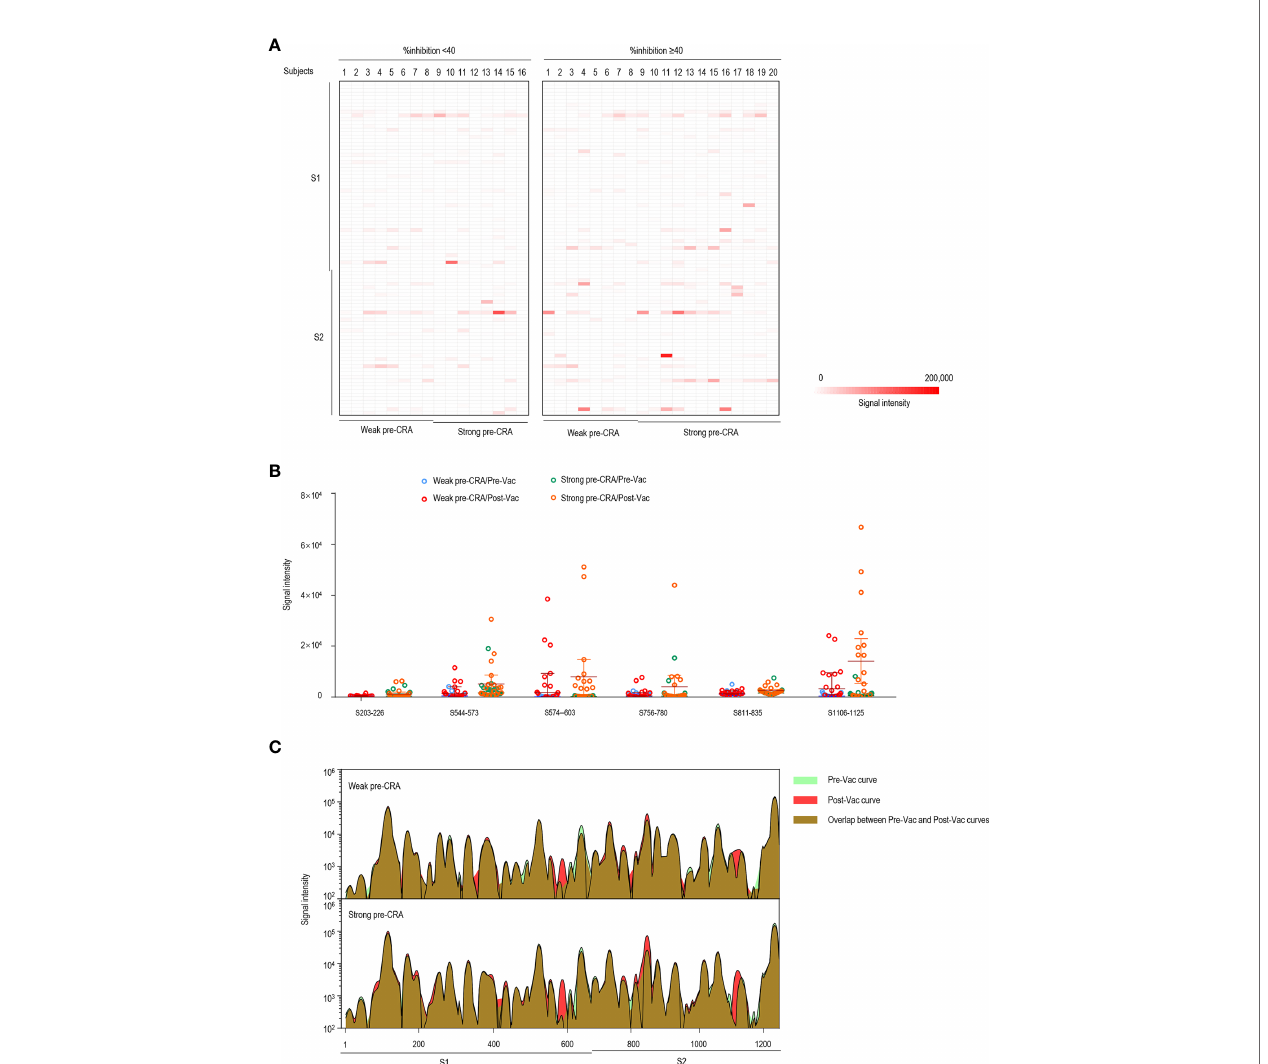
FIGURE 5 | The impact of pre-existing cross-reactive antibodies on vaccine-induced IgM response. (A) The IgM antibody responses to linear peptides of the S protein in vaccinated individuals. The heatmap is formed by subtracting the corresponding pre-vaccination fl uorescence readings from post-vaccination readings, representing the increase in fl uorescence intensity after immunization. (B) The changes in IgM signal intensities to six signi fi cant epitopes in paired sera before and after vaccine immunization, as separately shown in the strong pre-CRA and weak pre-CRA groups. (C) Global pro fi les of IgM responses to linear peptides of the S proteins in the strong pre-CRA (n=20) and weak pre-CRA (n=16) sera. The graphs are plotted as median values of the IgM responses to linear peptides of the S protein. Blue, pre-vaccination curve; Red, post-vaccination curve; Purple, the overlap between pre-vaccination and post-vaccination curves. Pre-Vac, pre- vaccination; Post-Vac,